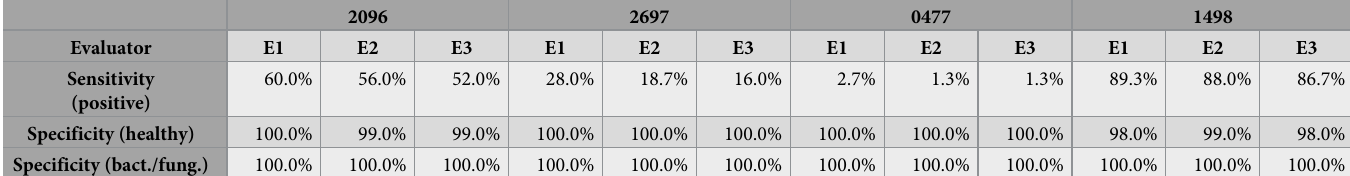
Table 2. Sensitivity and specificity values reported for single antigens and three different